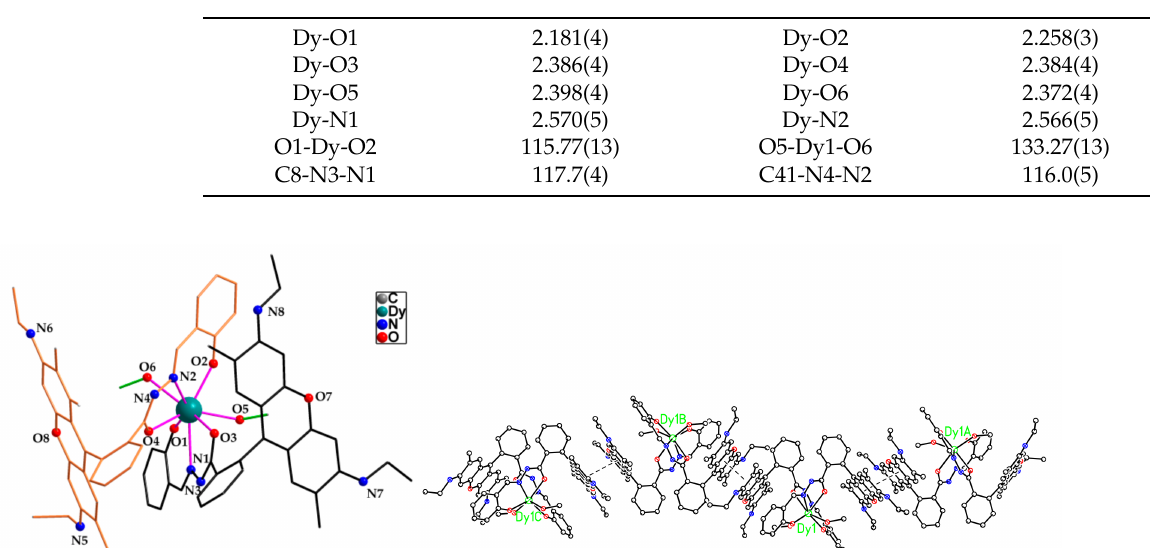
Table 2. Selected bond distances (Å) and bond angles ( ◦ ) for Complex 1 .